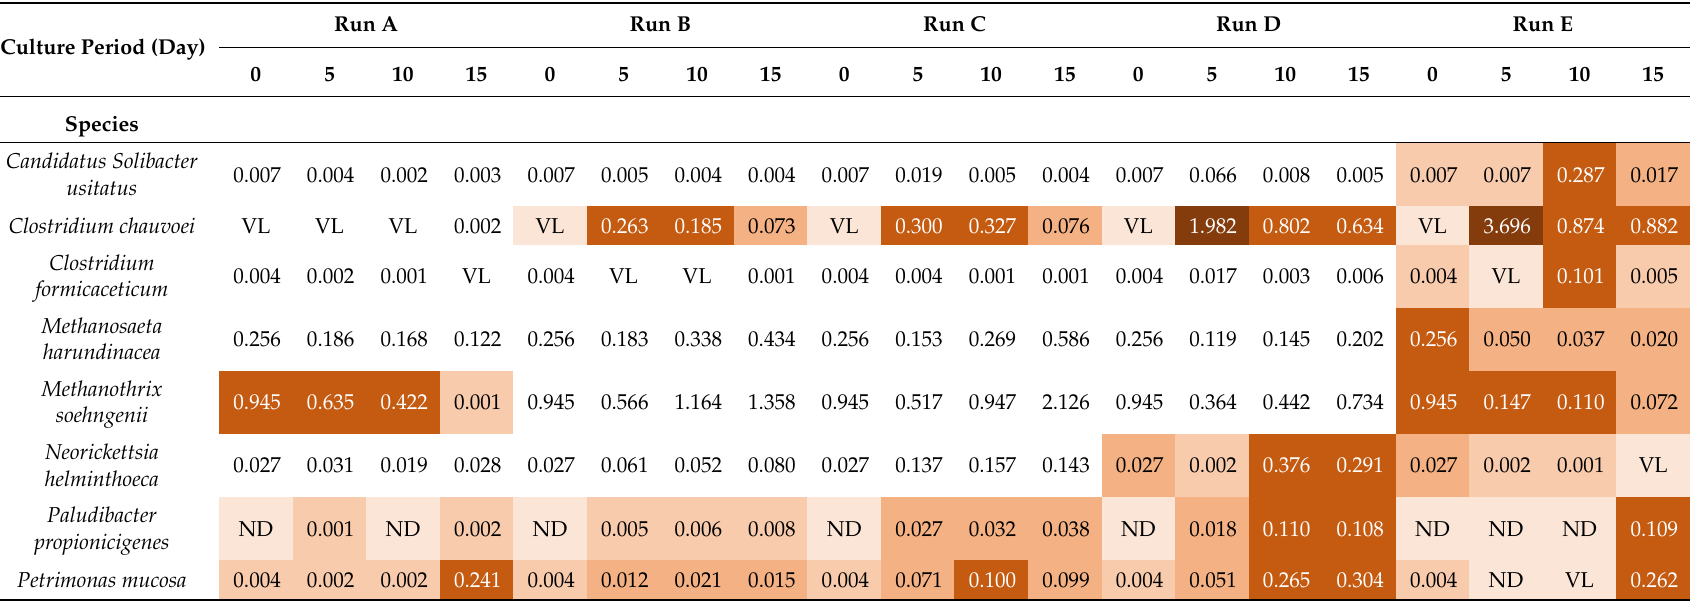
Table 3. Representation of the species revealed drastic changes in population in runs A, B, C, D, and E. Culture Period (Day)